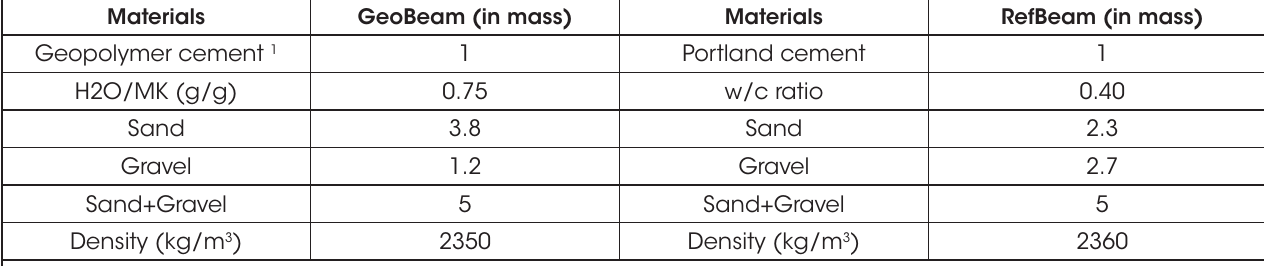
Composition of concretes used to produce RefBeam e GeoBeam beams